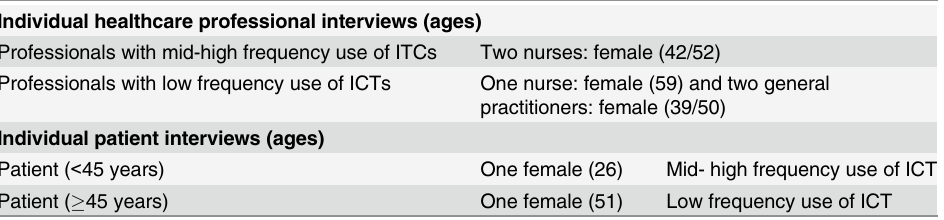
Table 1. Individual interviews.